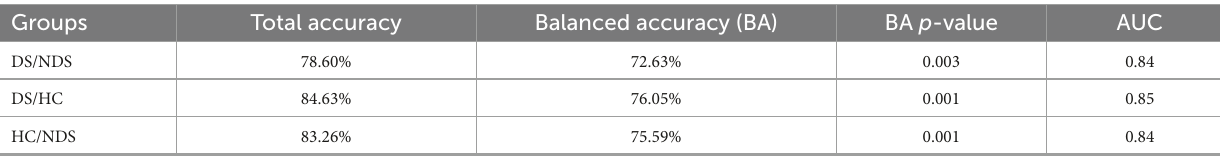
TABLE 2 Classification results of deficit schizophrenia (DS)/non-deficit schizophrenia (NDS)/healthy control (HC) using support vector machine (SVM) classifier based on gray matter volume (GMV).